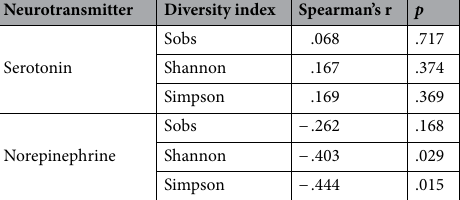
Neurotransmitter